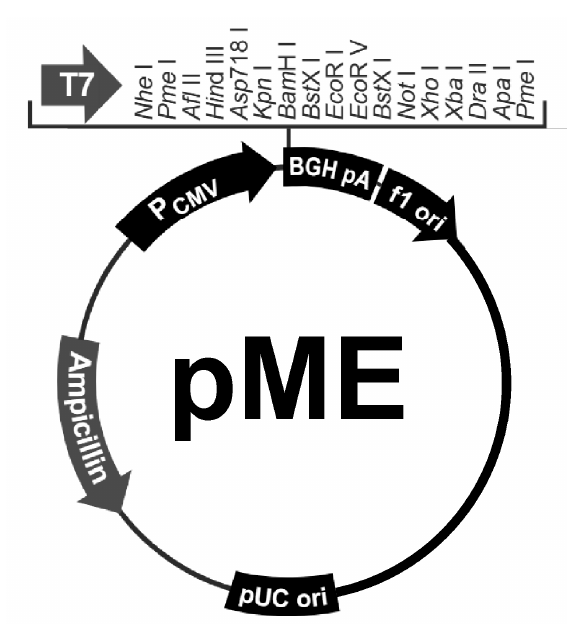
Figure A1. Map of the pME expression plasmid. PCMV, promotor of human cytomegalovirus; BGH pA, bovine growth hormone poly A signal; ori, origin of replication from pUC or bacteriophage f1; Ampicillin, gene for Ampicillin resistance ampR.